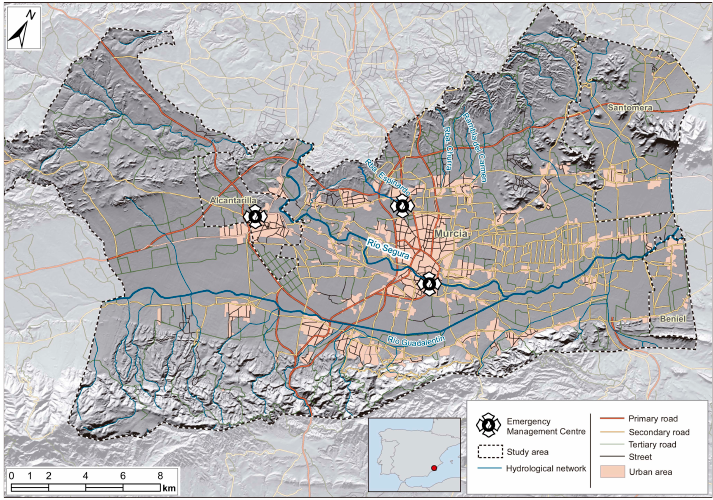
Figure 3. Study area including urban area, road network, and emergency management